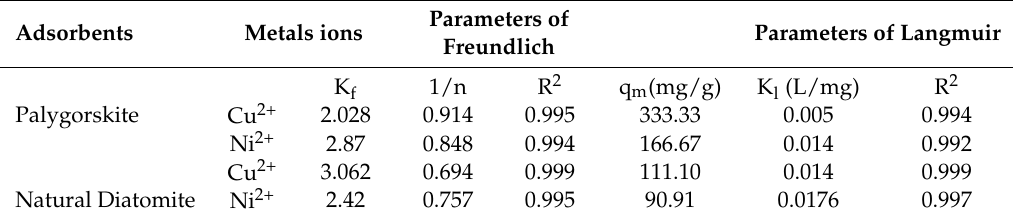
Table 3. Langmuir and Freundlich isotherm parameters for Cu 2+ and Ni 2+ adsorption onto treated diatomite and